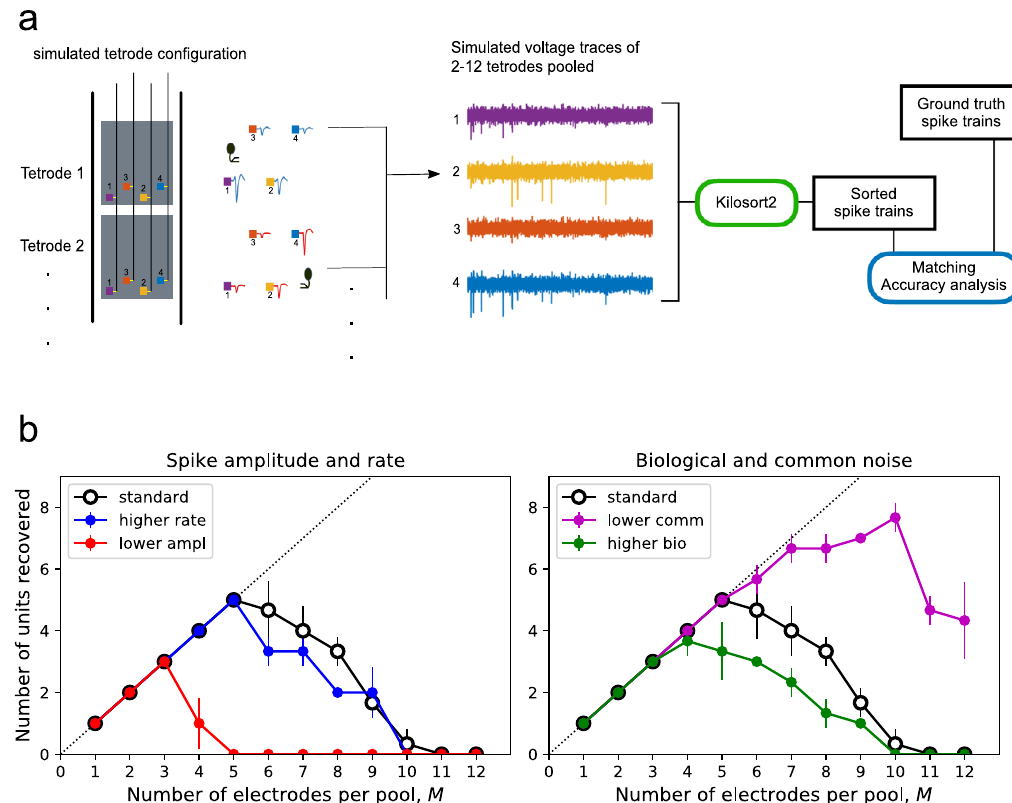
Fig. 6 Simulations of electrode pooling. a Work fl ow: Groups of four recording sites ("tetrodes") each carry a spike train from one simulated unit, superposed with electrode noise and biological noise. Between M = 1 and 12 of these tetrodes are then pooled into a single 4-wire recording followed by the addition of common noise. The pooled signal is sorted and the resulting single-unit spike trains are matched with the ground truth spike trains from the M tetrodes. Units with an accuracy metric> 0.8 are counted as recovered successfully. b Number of units recovered as a function of the pool size, M , under various conditions of the simulation. Effects of varying different parameters. The "standard" condition serves as a reference: Spike amplitude V = 380 μ V, spike rate r = 10 Hz, electrode noise N ele = 1.6 μ V, common noise N com = 5.7 μ V, biological noise N bio = 9 μ V. "lower ampl": V = 205 μ V. "higher rate": r = 20 Hz. "higher bio": N = 15 μ V. "lower com": N = 2.85 μ V. Each parameter combination was simulated three times with noise and spike times bio com resampled, error bars are mean ±